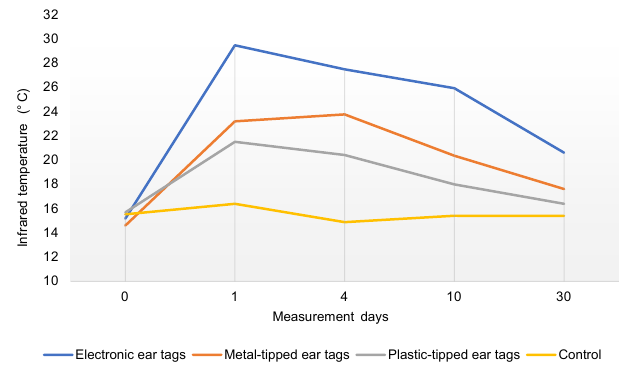
Figure 5. Comparison of the infrared ear temperature of the exper- imental and control group of lambs according to the measurement